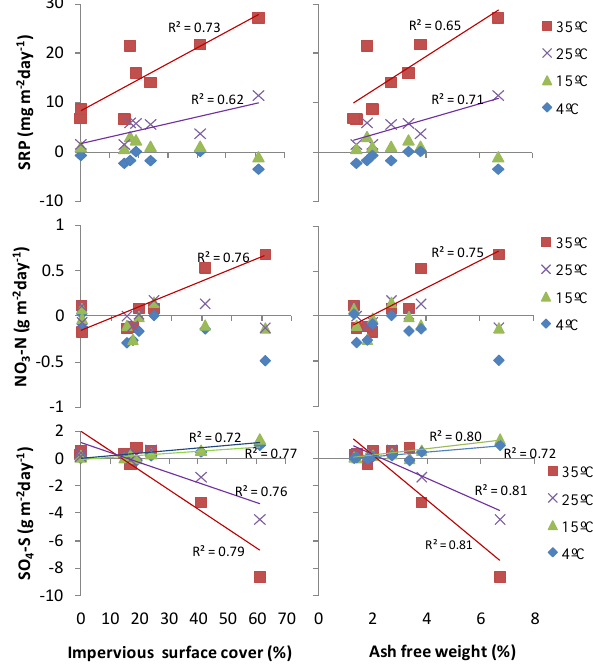
Fig. 7. Relationship of sediment fluxes of nitrate, SRP and sulfate with watershed impervious surface cover and percent of sediment ash weight. Best fit regressions were linear, and only regressions with significance < 0 . 05 were applied. For the sulfate at 35 ◦ C- incubations, the linear regression seems to be strongly influenced by the two heavily urbanized sites with highest % ash weight, while there is a large amount of cluster of data at lower impervious surface cover and lower % ash